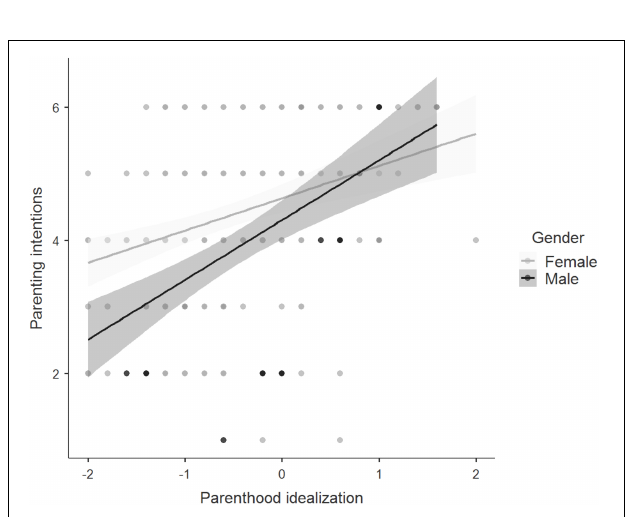
FIGURE 2 | Regression plot showing the relationship between idealization of parenthood and the strength of parenting intentions among men and women. Points represent individual responses, n = 264 and the gray shaded region represents the 95% confidence region. For idealization, responses were on 5-point Likert scale with higher scores indicating a stronger belief that parenthood offers emotional benefits. For the strength of parenting intentions, responses were on 6-point Likert scale with higher scores indicating a stronger intent to become a